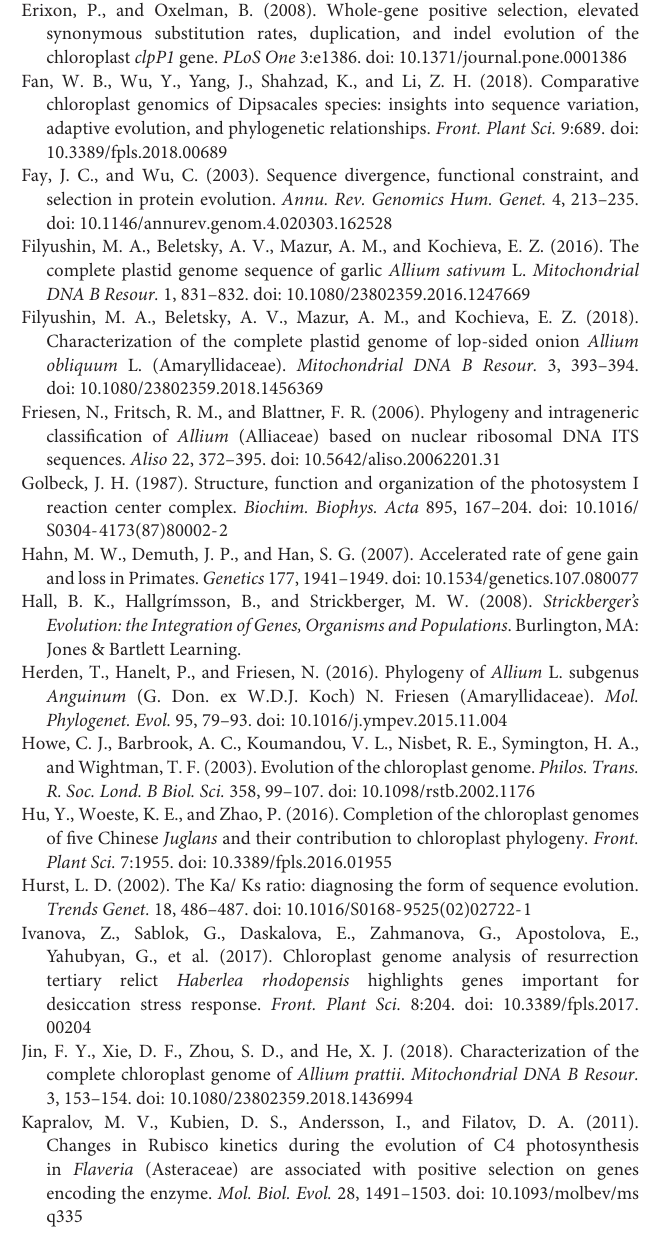
FIGURE S3 | Phylogenetic tree reconstruction of 41 taxa based on (A) the single copy gene sequences and (B) the CDS sequences. Numbers above the branches are the posterior probabilities of BI and the bootstrap values of ML, respectively. FIGURE S4 | Partial alignment of amino acids sequences in another eight positively selected genes. (A–H) : psaI , psbD , psbE , psbM , ndhE , and ndhG , ycf3 and rps4 . The red blocks stand for the amino acids in Allioideae with a high BEB posterior probability. TABLE S1 | Information for sample collection. TABLE S2 | Primers used for gap closure in this study. TABLE S3 | The Genbank accessions of all 41 taxa cp genome sequences used this study.